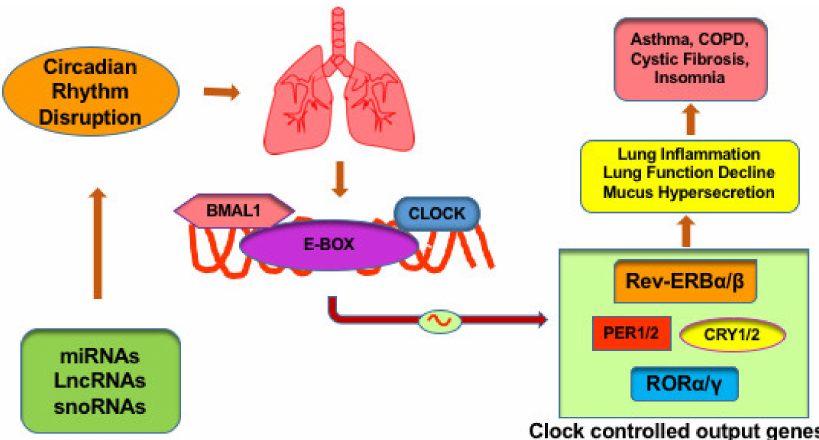
Figure 1. Schematic representation of ncRNAs regulation of lung molecular clock. Clock-controlled output genes are involved in lung function homeostasis. Outputs from the molecular clock are generated through transcription or repression of target genes. Clock genes plays a significant role in the lung pathophysiology of inflammation and metabolism. In the lung, disruption of these genes has been shown to promote exacerbations in chronic obstructive pulmonary disease (COPD), asthma, mucus hypersecretion, nocturnal breathlessness, insomnia as well as chronic